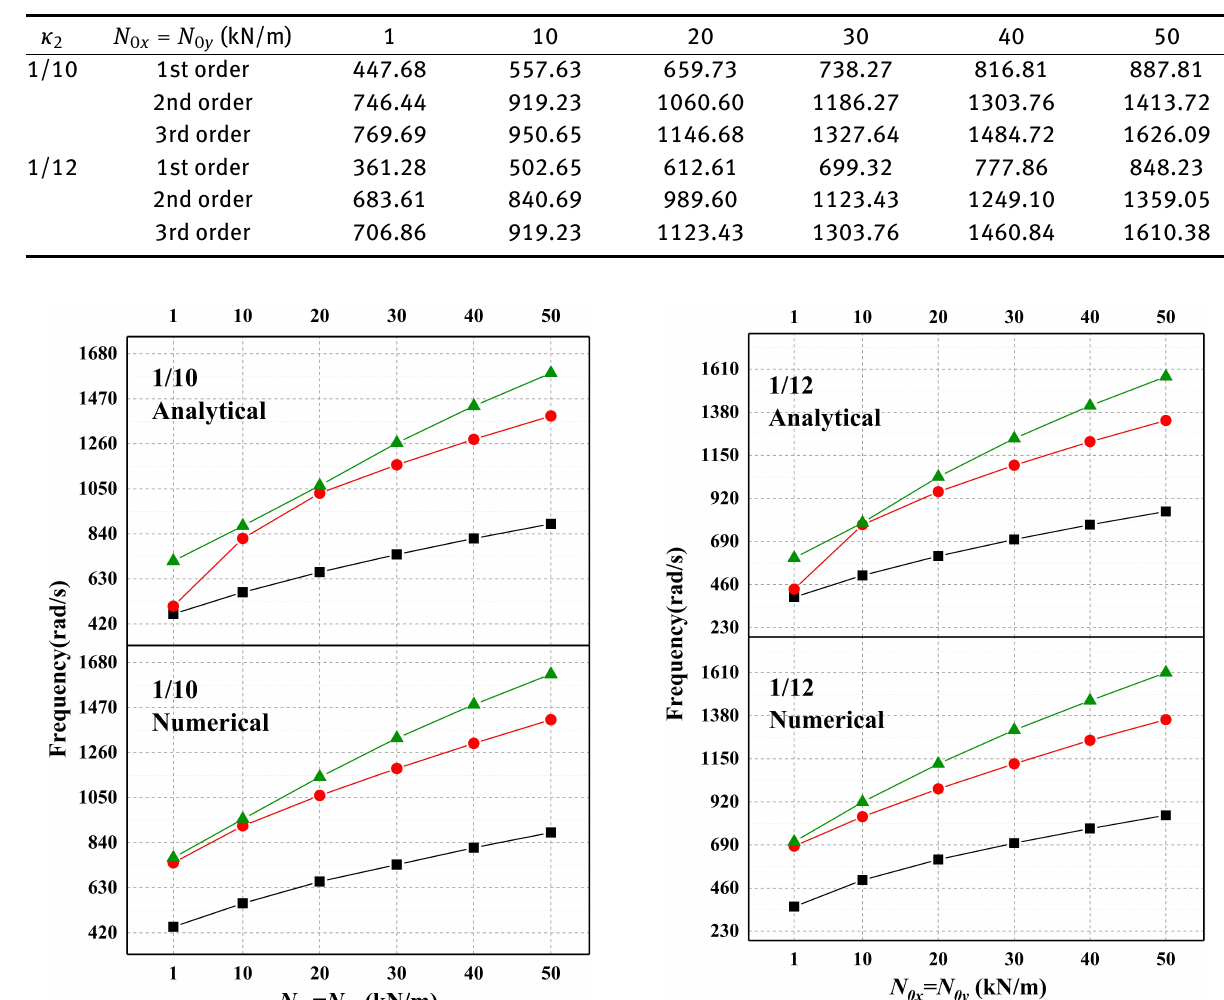
frequency increases with the increase of order under the same prestress.